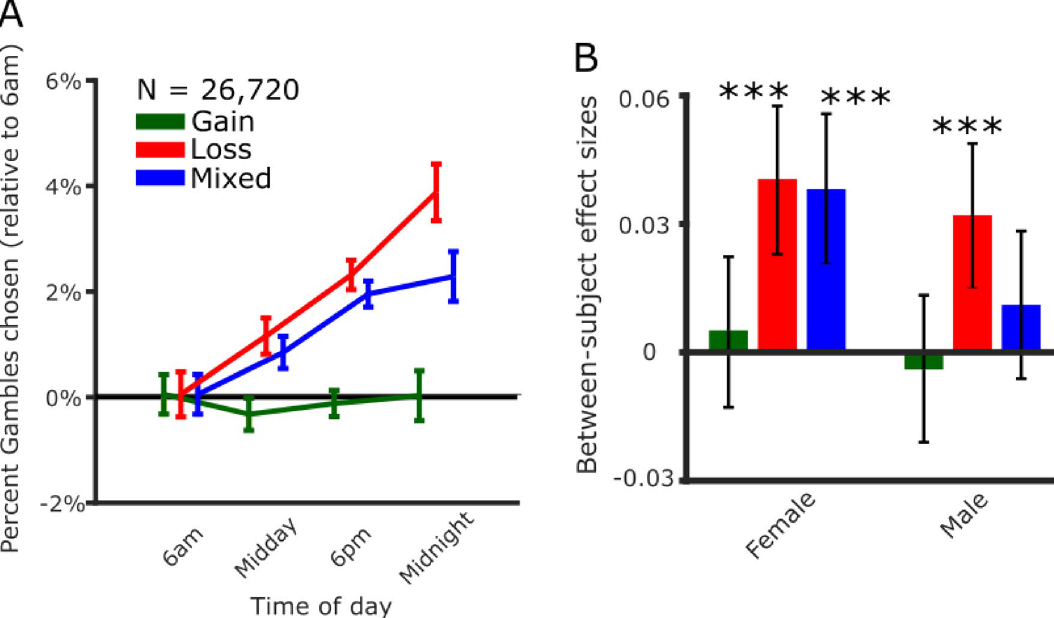
Figure 3. Risk taking for potential losses increases with time of day. ( A ) Risk taking in choice trials with potential losses increased with time of day (N = 26,720, first plays only). This was true in loss trials featuring risky options with equal probabilities of zero or a potential loss, and in mixed trials featuring risky options with equal probabilities of potential gains and losses. The frequency of choosing risky options with only potential gains was unaffected by time of day. Each time bin includes data collected in the interval starting at the time indicated (i.e., the 6am bin includes all data collected from 06:00 until 11:59). Error bars represent the SEM. ( B ) Risk taking in loss trials increased with time of day in both female (N = 13,054) and male participants (N = 13,666). Risk taking in mixed trials increased with time of day in females but not males. Error bars represent bootstrapped 95% confidence intervals [* p < 0.05, ** p < 0.01, *** p <